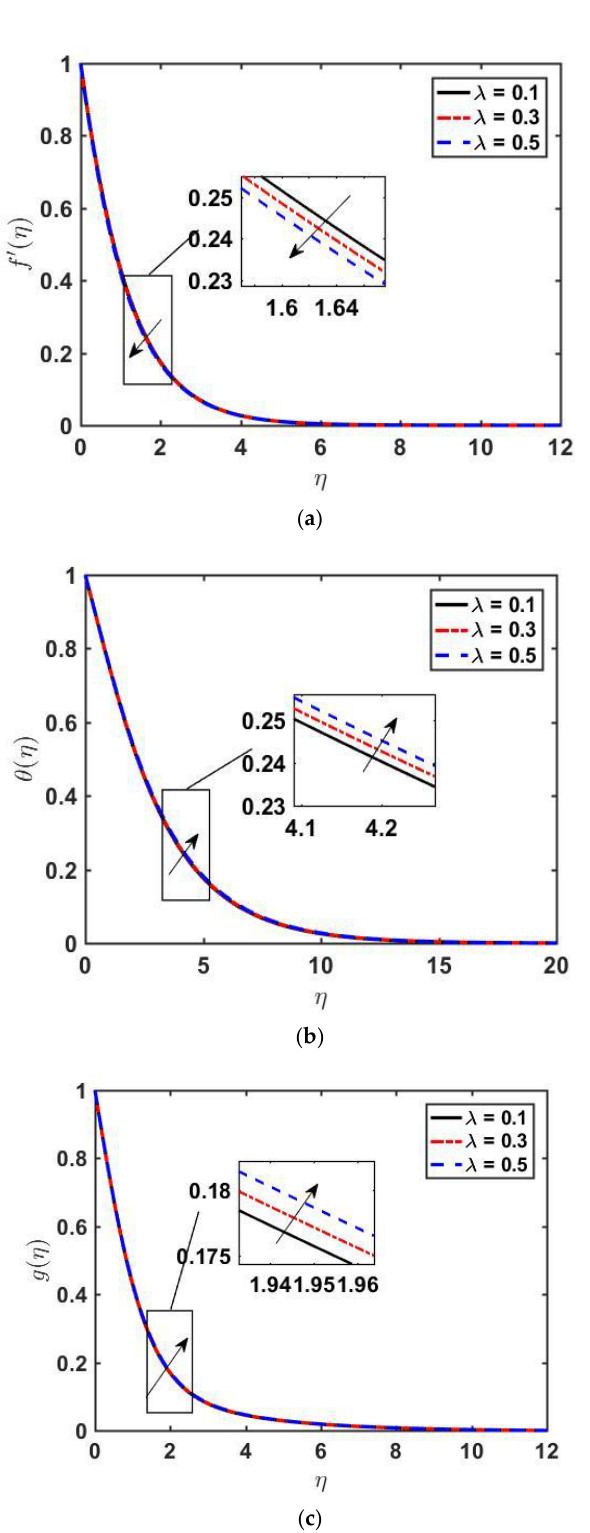
Figure 2. Profiles of 𝑓′(𝜂) , 𝜃(𝜂), and g(η) versus 𝜂 for various values of 𝜆 by fixing 𝑀 = 0.5, 𝑃𝑟 = 0.5, 𝐿𝑒 = 3.0,𝑁𝑏𝑡 = 2.0, 𝑁𝑐 = 0.5, and 𝑆𝑐 = 2.0 .